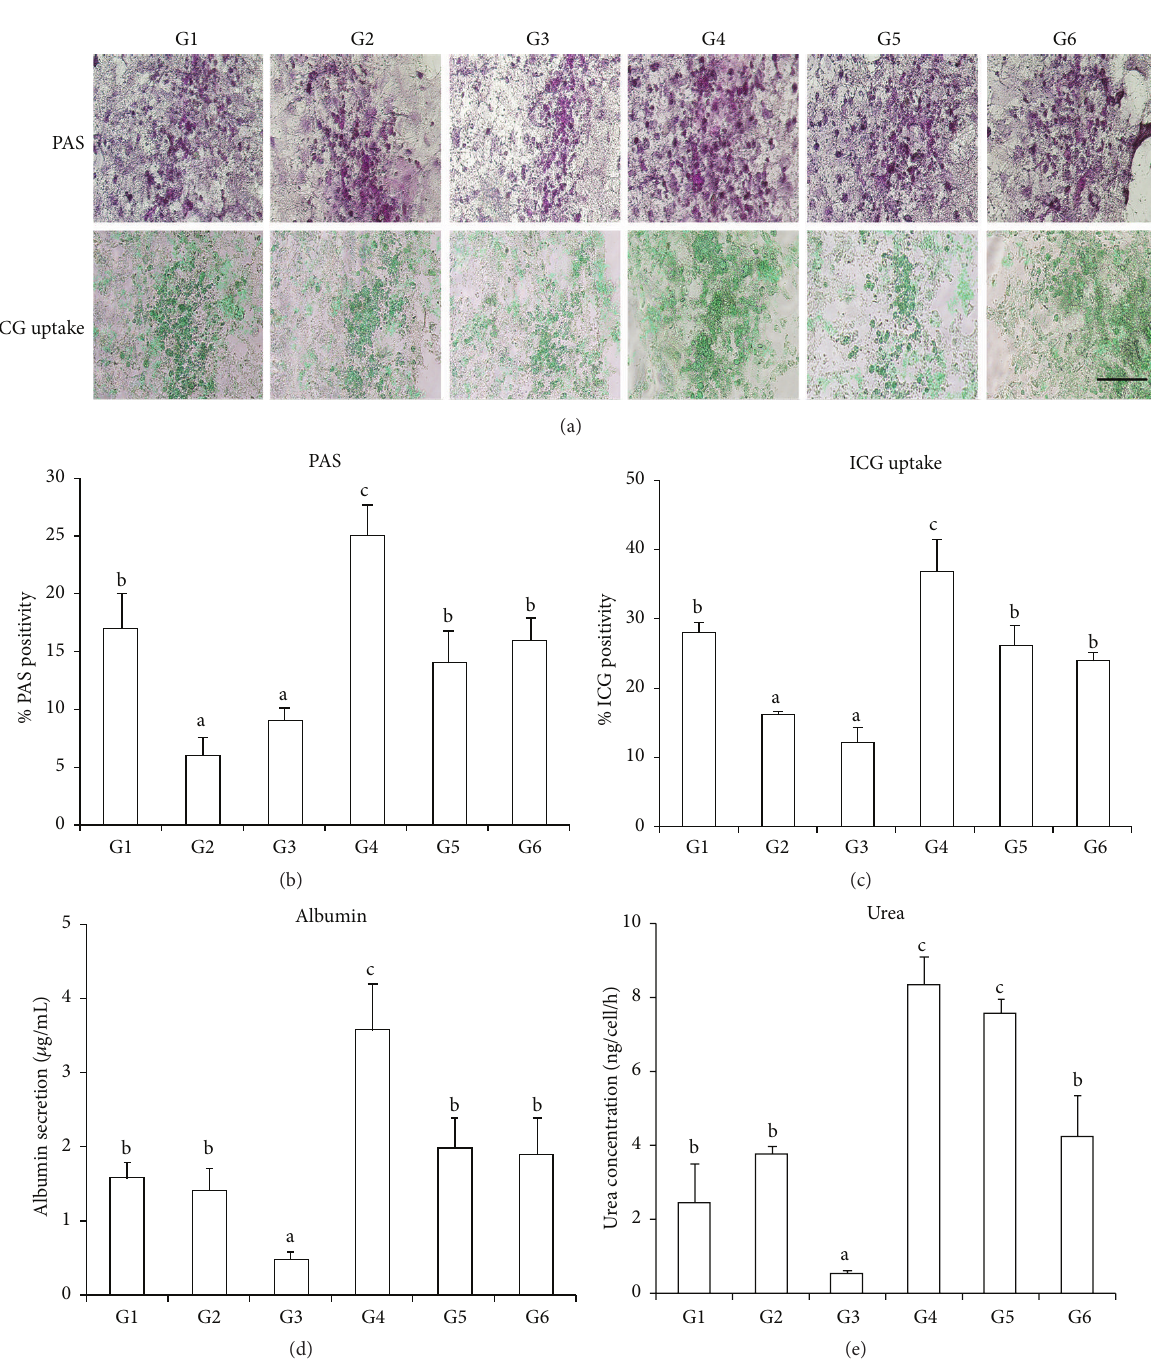
Figure 2: Comparative analysis of hepatocyte-like functions on the last day of hepatic differentiation. (a) Periodic acid Schiff (PAS) assays showing glycogen-positive cells and ICG uptake in each experimental group. (b and c) Number of glycogen-positive cells. (d) ALB secretion. (e) Urea production. Bars with different superscripts are different statistically ( 𝑝 < 0.05 ). a , b 𝑝 < 0.05 , b , c 𝑝 < 0.05 . Scale bar: 100 𝜇